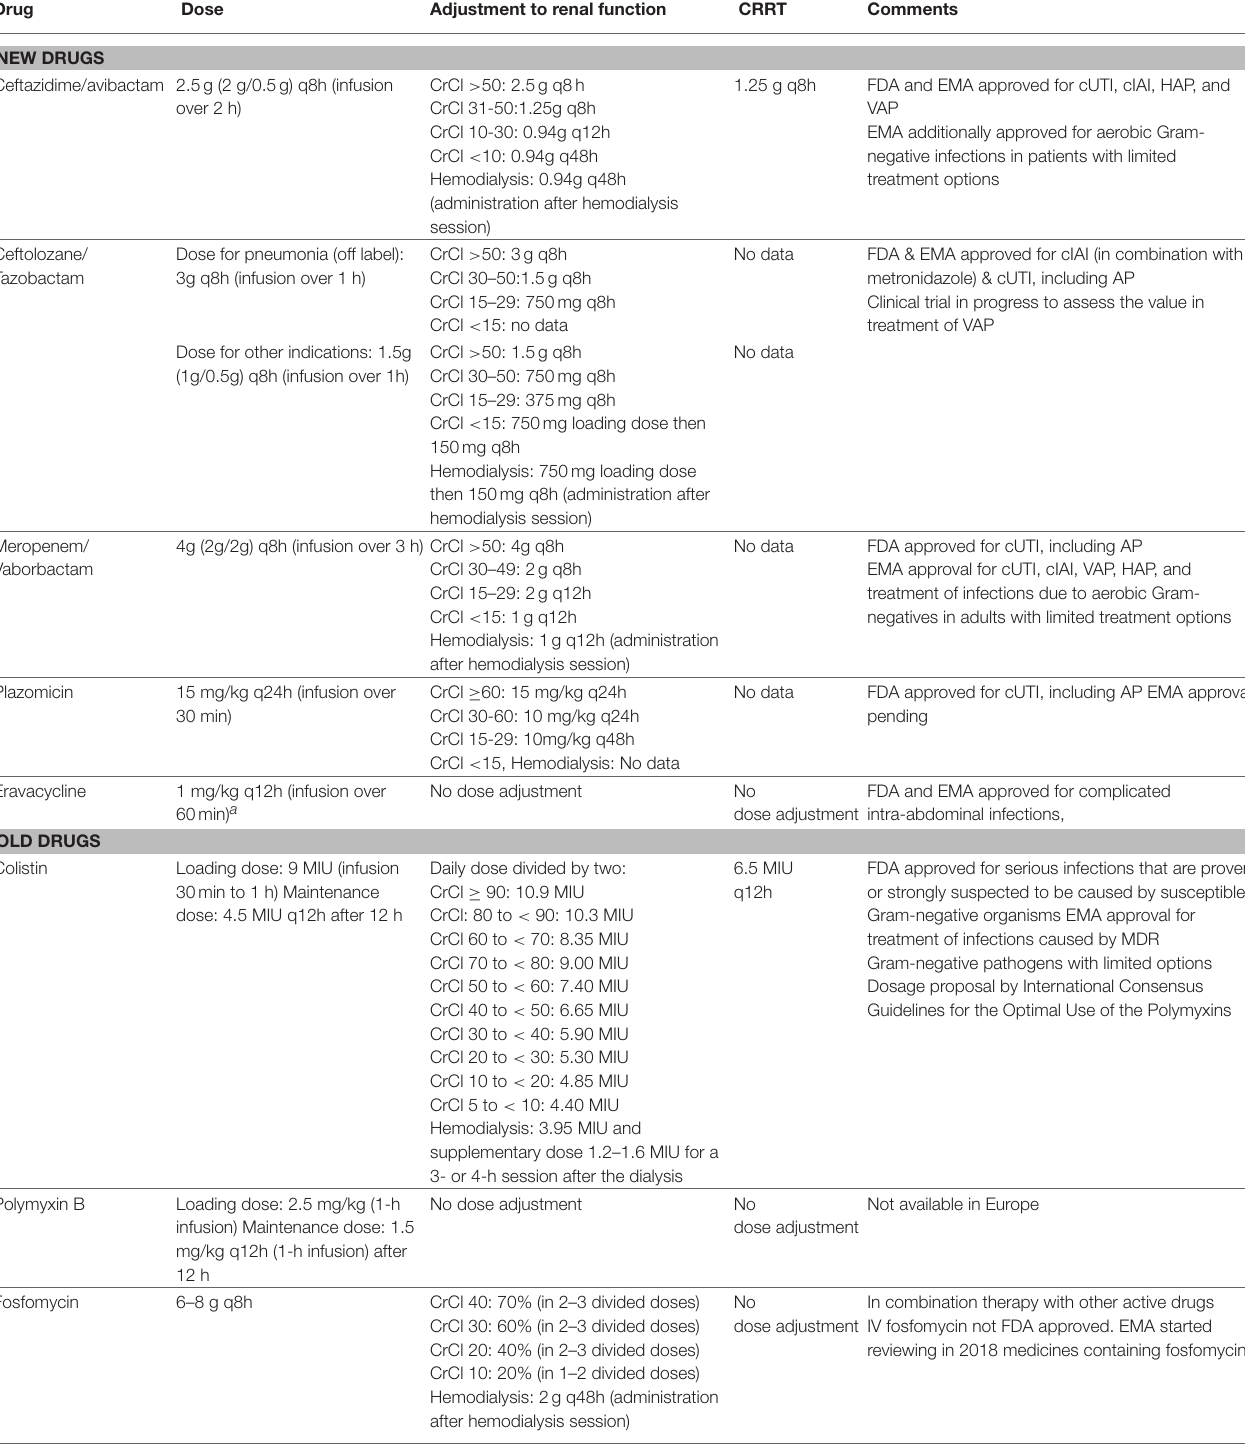
TABLE 2 | Intravenous novel and older antimicrobial agents against MDR and XDR Gram-negative pathogens (1, 8, 24–26, 59, 64, 99, 110, 113–122, 136). Drug Dose Adjustment to renal function